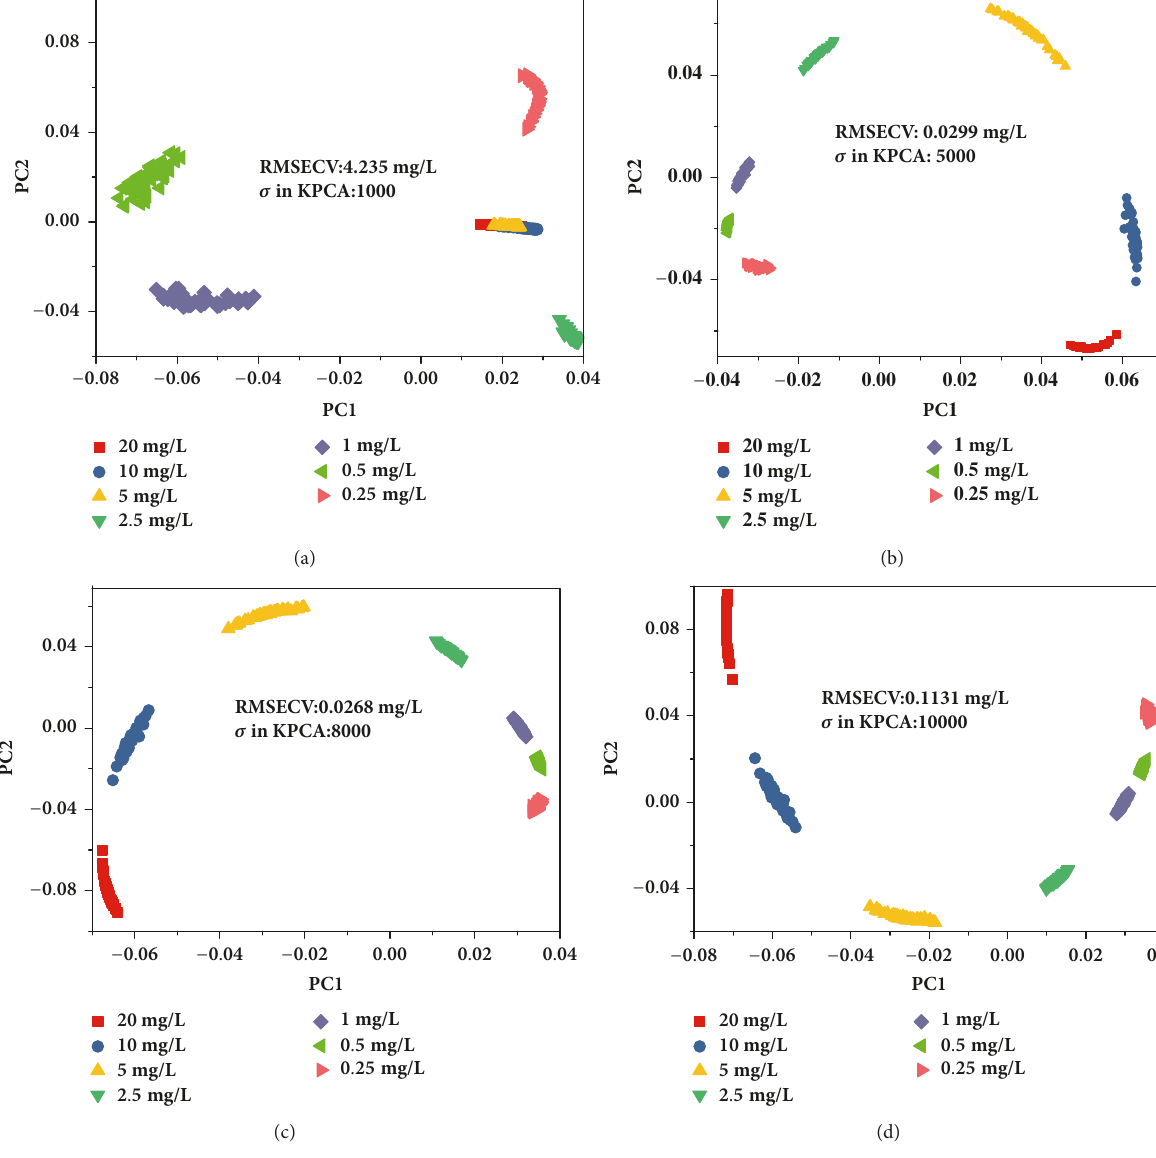
Figure 5: Scatter plot of first two principal component scores obtained by KPCA with 𝜎 of 1000 (a), 5000 (b), 8000 (c), and 10000 (d); PC1: the first principal component. PC2: the second principal component. Table 2: Predicted results of 15, 8, 4, and 2 mg/L of chlormequat chloride in wheat extraction solution using SERS, SVR, and KPCA. Spiked value ( 𝜇